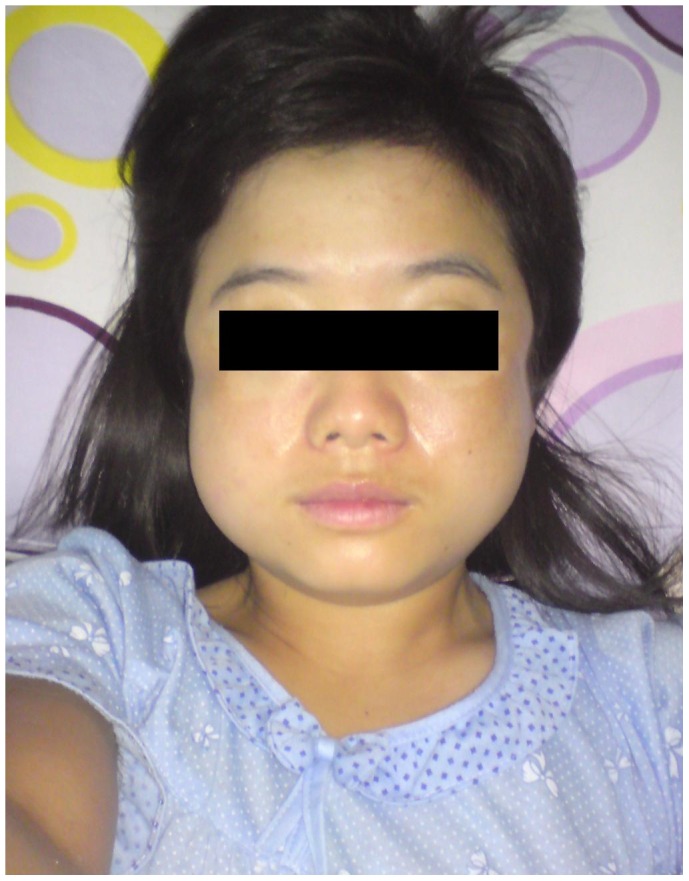
32 year old student from China with facial swelling from swollen temporalis and masseter muscles (Case 1, Table 3).